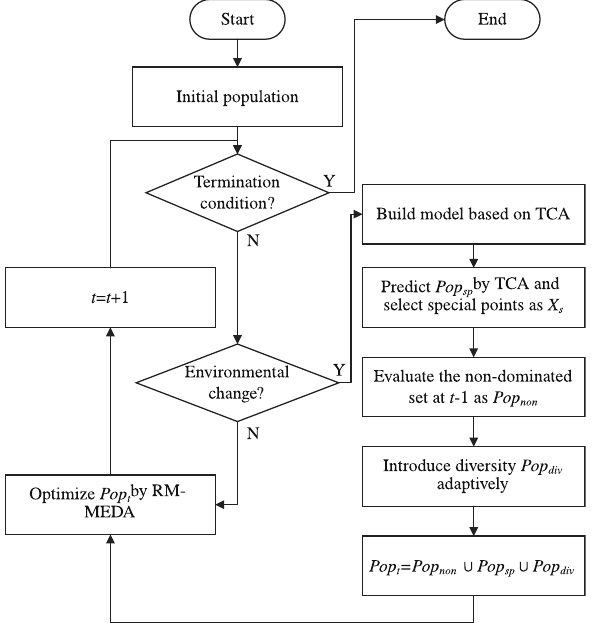
Fig. 1 The diagram of the overall algorithm